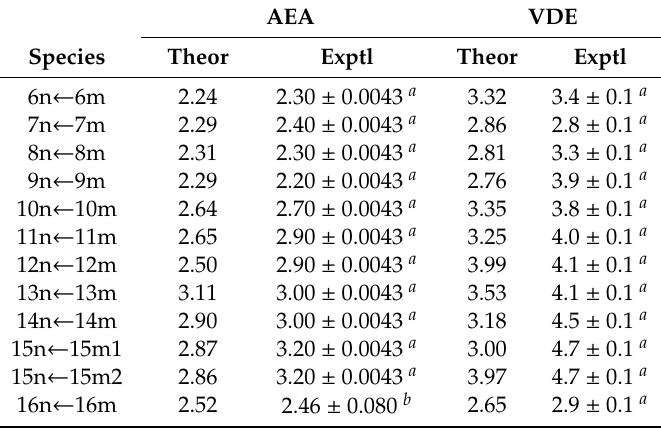
Figure 4. Photoelectron spectroscopy (PES) spectra of the most stable ZrSi n - ( n = 6–16) clusters. The inserts show the experimental PES spectra taken from [22,23]. Table 2. Theoretical and experimental adiabatic electron affinity (AEA) and vertical detachment energy (VDE) for ZrSi n - ( n = 6–16).